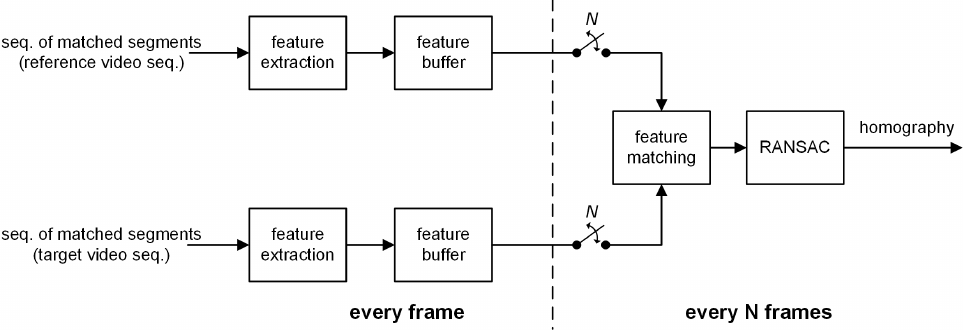
Figure 2. Homography estimation for a sequence of matched segment